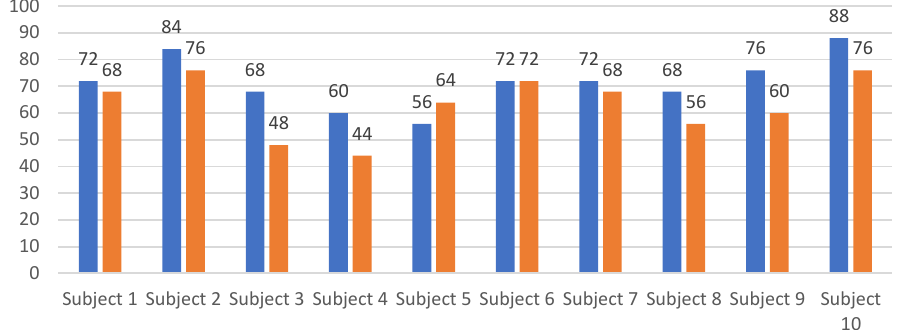
Figure 9. Word recognition scores of the standard and personalized ADRO as percentages in quiet conditions.